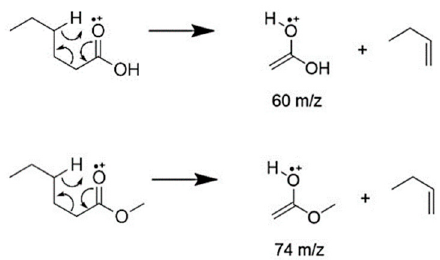
Figure 3. Mechanism and products of McLafferty’s rearrangement, typically occurring for esters in MS analysis.